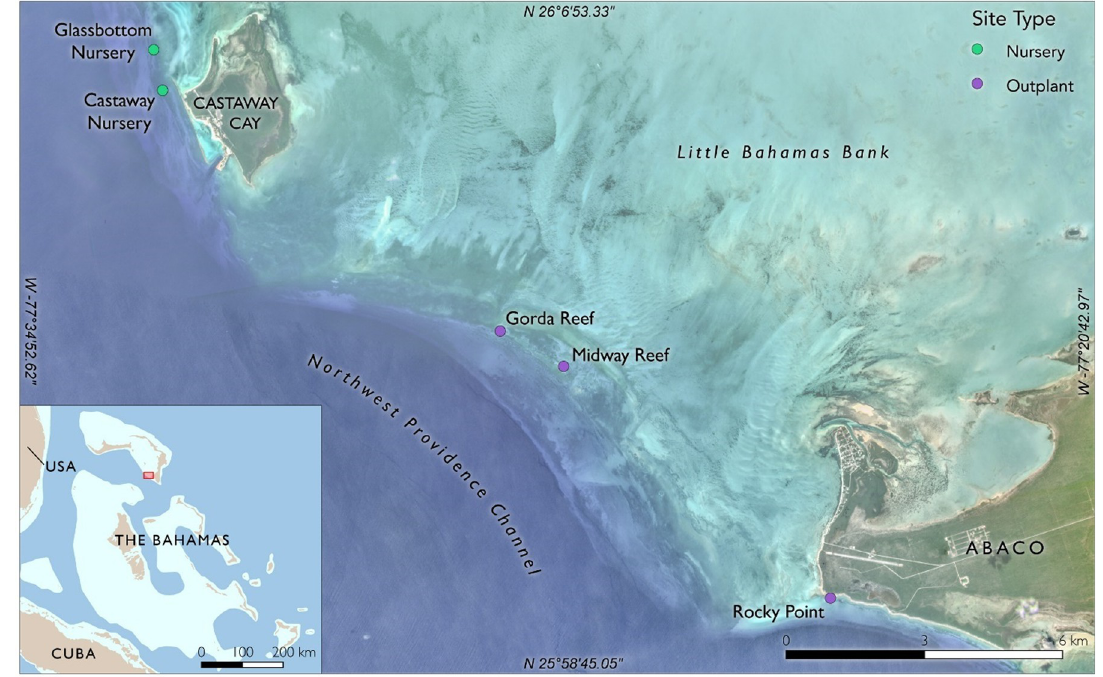
Fig 1. Location of two coral nurseries near Disney Castaway Cay, The Bahamas made using the free and open source geographic information system QGIS. Nursery locations are indicated by green dots.